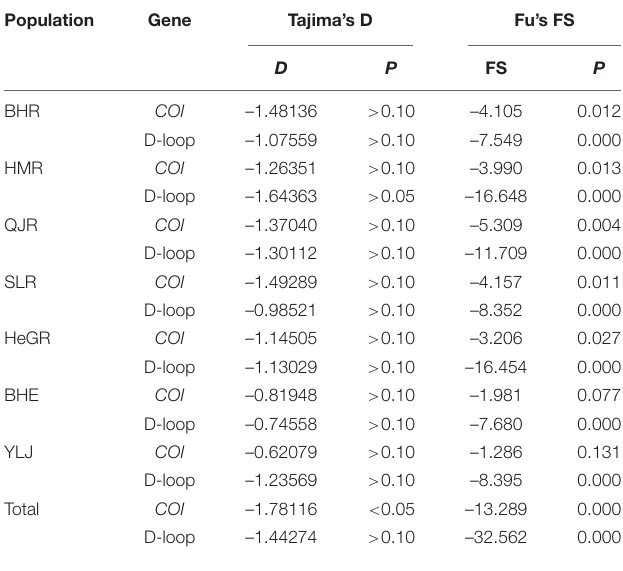
TABLE 6 | Neutrality test of G. przewalskii by two mitochondrial markers.